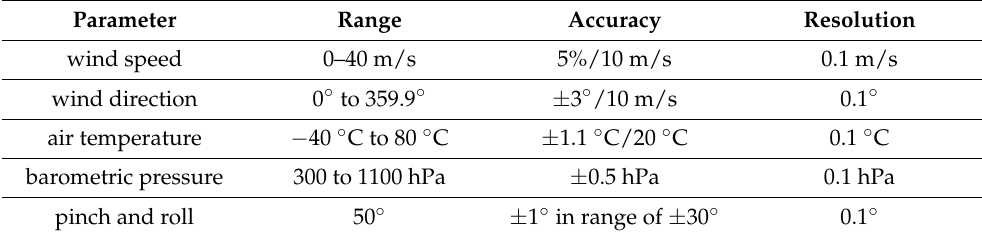
Table 2. The main characteristics of Airmar WeatherStation